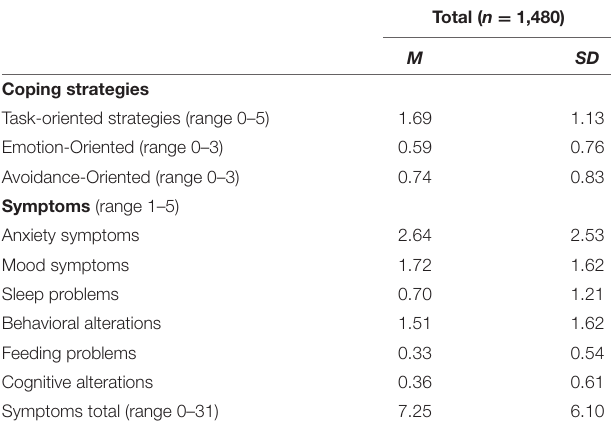
TABLE 3 | Coping strategies and psychological